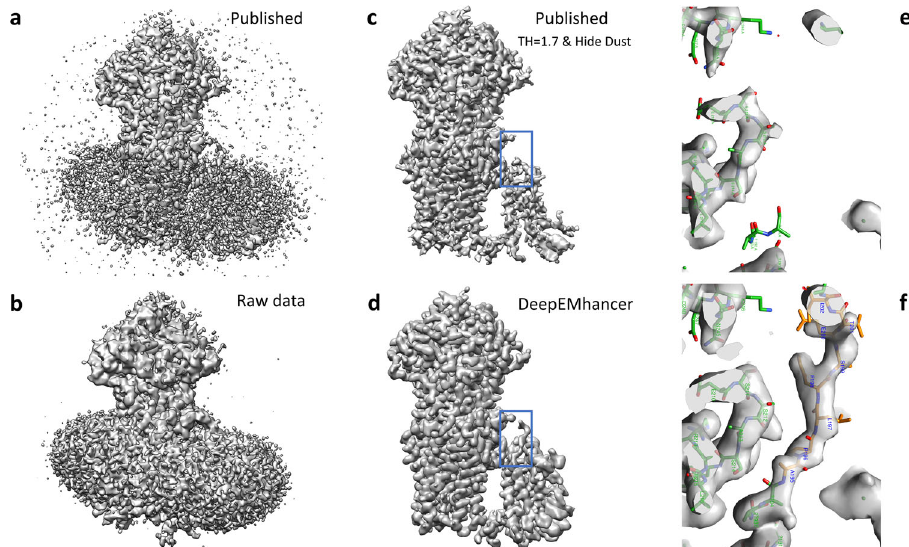
Fig. 4 DeepEMhancer results on testing map EMD-7099. a Lateral view of the published map ( B -factor sharpened, shown at the threshold recommended by the authors). b Lateral view of the raw data map obtained from the half maps that was used as input for DeepEMhancer. c Lateral view of the published map after rising the threshold and removing the small connected components so that the signal coming from the lipids was suppressed. As a collateral consequence, some densities corresponding to the protein were also lost. d Lateral view of the map obtained with DeepEMhancer. e Zoom-in of the region marked with a blue box in c . f Zoom-in of the region marked with a blue box in d , in which DeepEMhancer post-processed map, contrary to the published map, shows the densities corresponding to a missing loop in PDB 6bhu chain A. As a result, the residues A195 to I203 have been de novo modeled (new residues depicted in yellow, published in